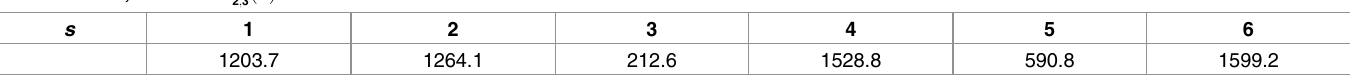
Table 9. M = 2, model 3: D ð s Þ